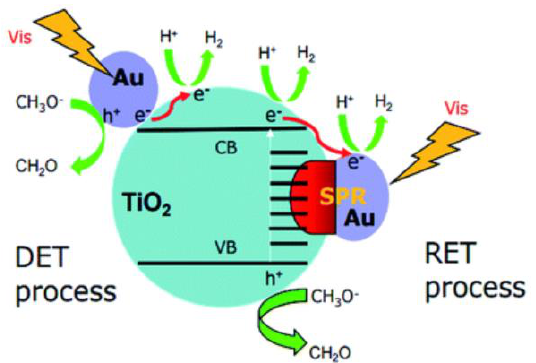
Figure 3. The visible light activity of Au–TiO 2 explained by two electron transfer mechanisms: resonance energy transfer process (right) and direct electron transfer process (left). Reprinted with permission from Nie, J.; Scheneider, J.; Sieland, F.; Zhou, L.; Xia, S.; Bahnemann. New insights into the surface plasmon resonance (SPR) driven photocatalytic H 2 production of Au-TiO 2 . RSC Adv. 2018, 8 , 25881–25887. Copyright 2018 The Royal Society of Chemistry [63].